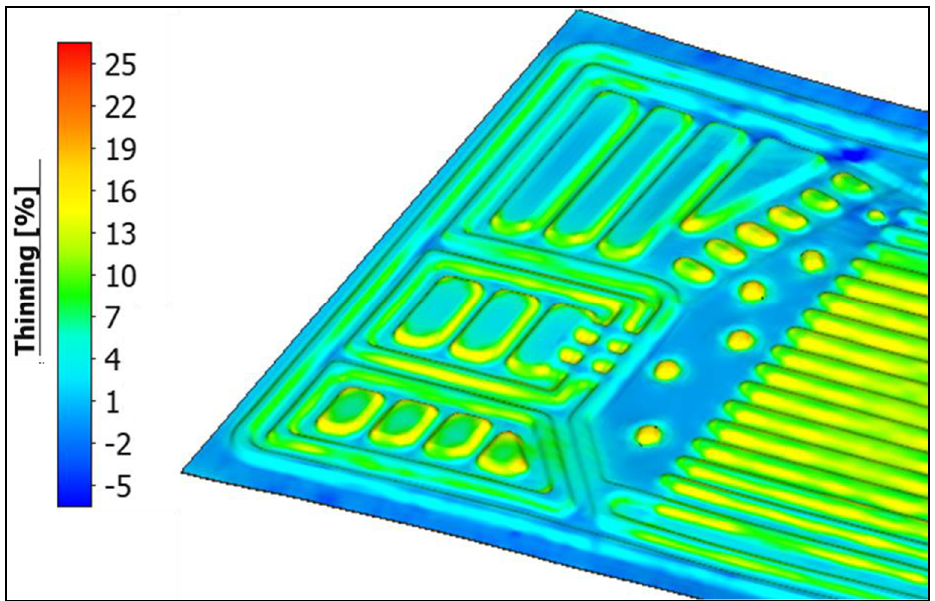
Figure 7. Thinning of the shaped bipolar plates.